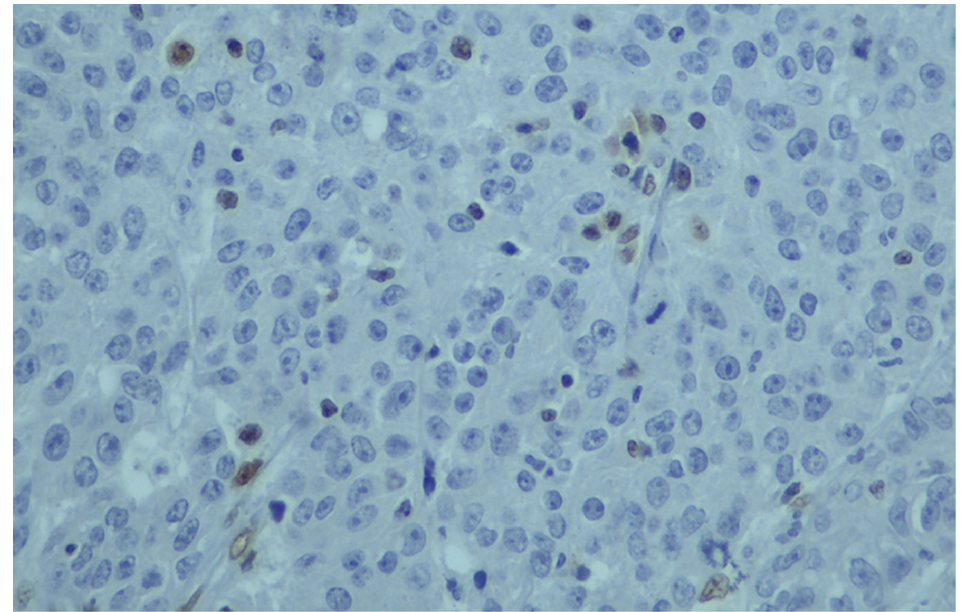
Figure 3. Immuno-histochemical staining of MLH1 in a few tumor cells which contradicts the result of fragment analysis.